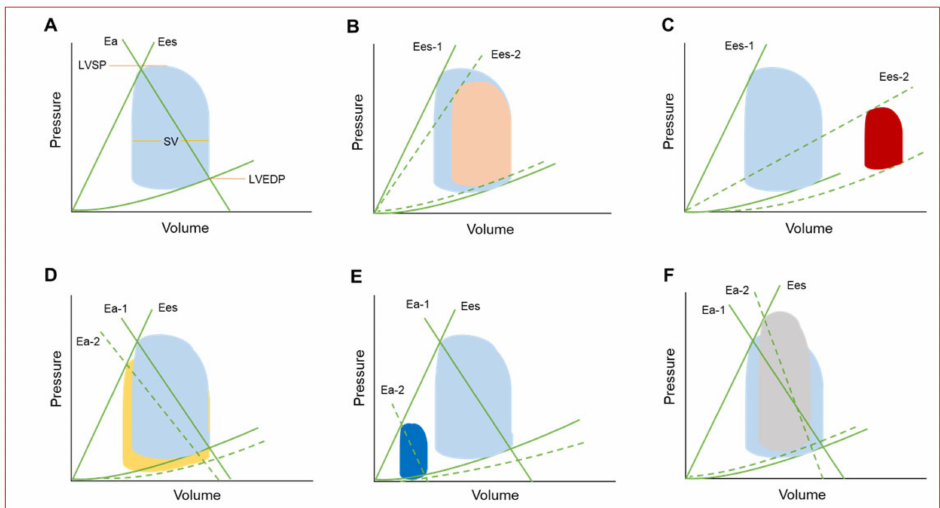
Figure 1. ( A ) Normal pressure-volume (PV) loop. E ff ective arterial elastance (Ea) is the slope of the line extending from the left ventricular (LV) end-diastolic pressure-volume point through the end-systolic pressure-volume point of the loop. Ea is determined by the total peripheral resistance and heart rate and gives an estimate of the LV afterload. End-systolic elastance (Ees) is the slope of the line extending